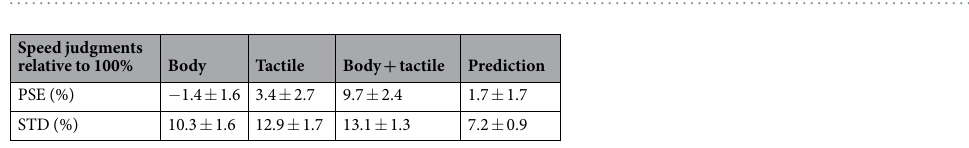
= ∗ + tactile body body The best-fit weights were body = 0.6 and tactile = 0.49 (total 1.09, r = 0.94, p < 0.001) and hence the predicted